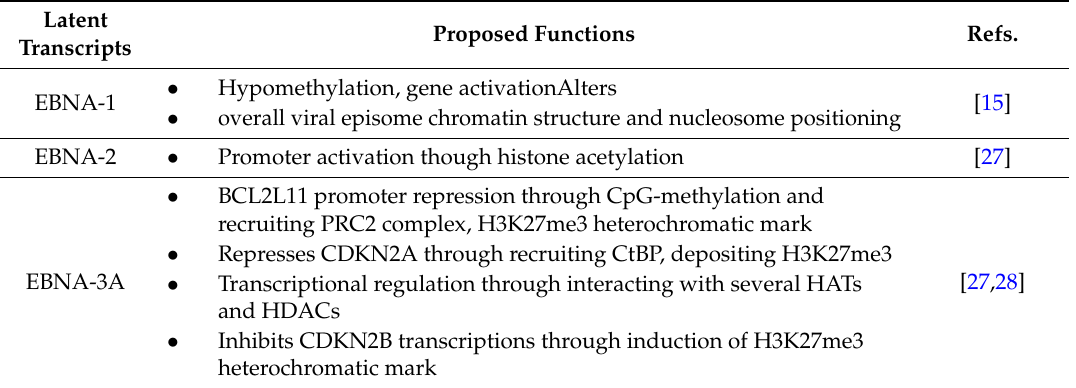
Table 2. Role of EBV latent transcripts in epigenetic deregulation during B-cell